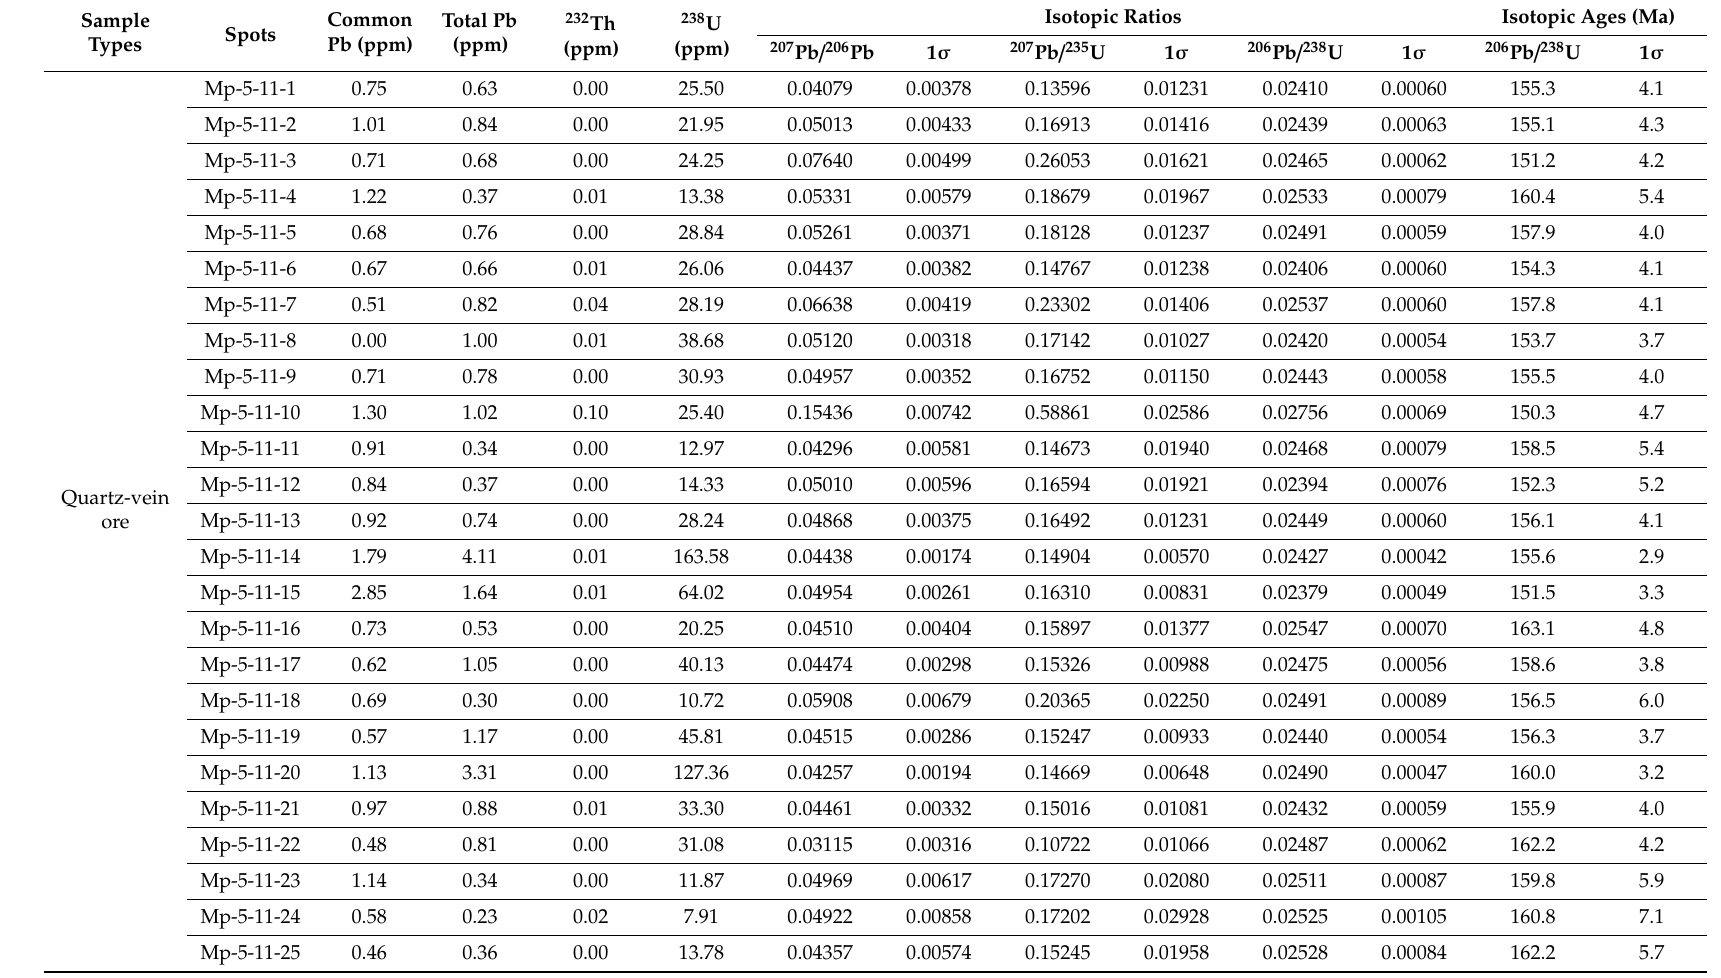
Table 2. LA-ICP-MS U–Pb dating results of cassiterite from the Maoping W–Sn